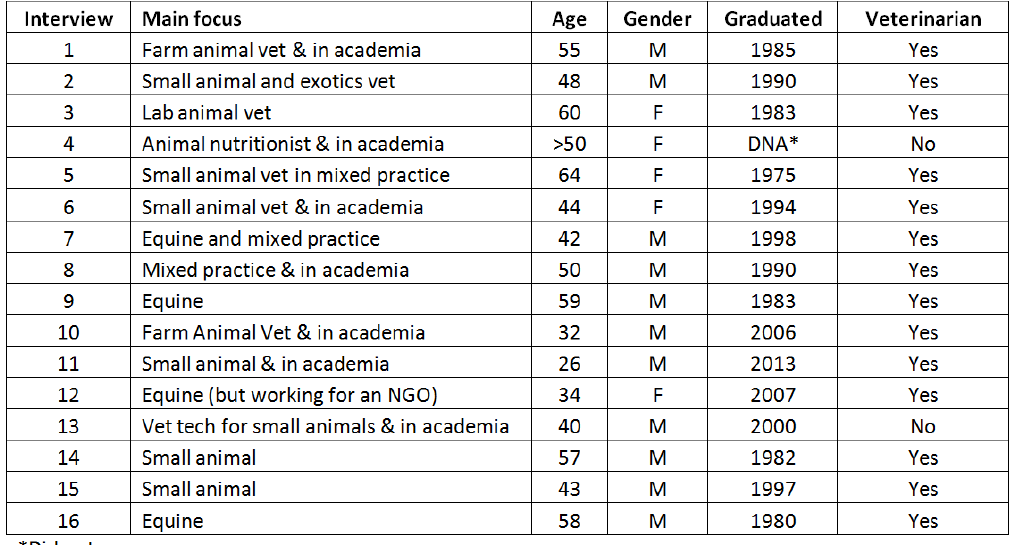
Table 1 : An overview of interview participant